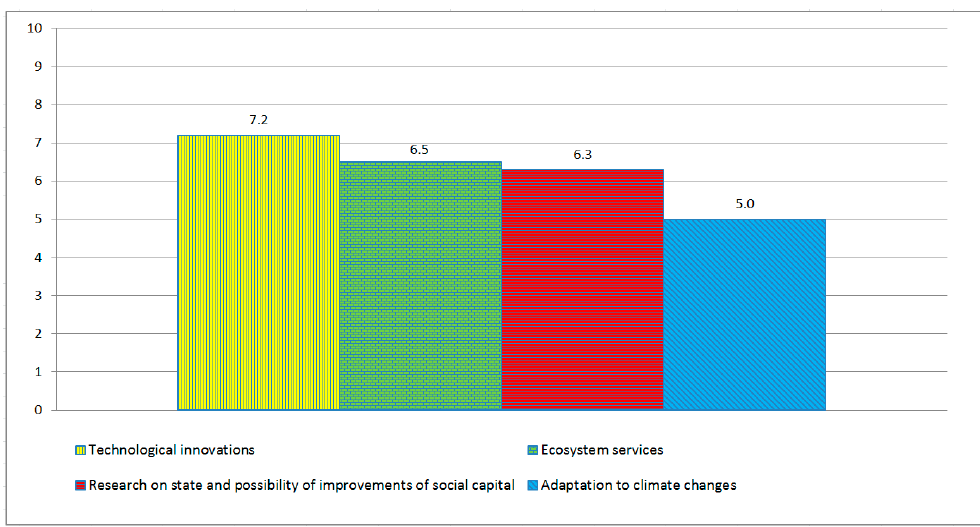
Figure 6. Compatibility of the Polish Recovery Plan with the key research areas identified. Source: Study results.